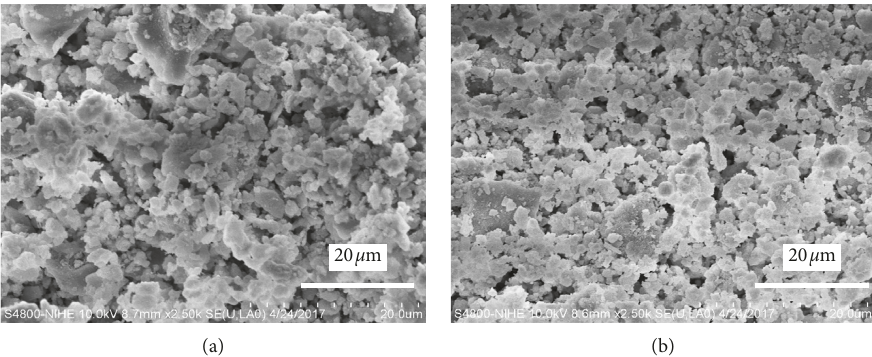
Figure 3: SEM images of (a) H ° C for 4h. 2 and (b) H 3 granules sintered at 600 Table 2: The effect of sintering temperature on the color, durability in water, and specific surface area of H 3 granules.